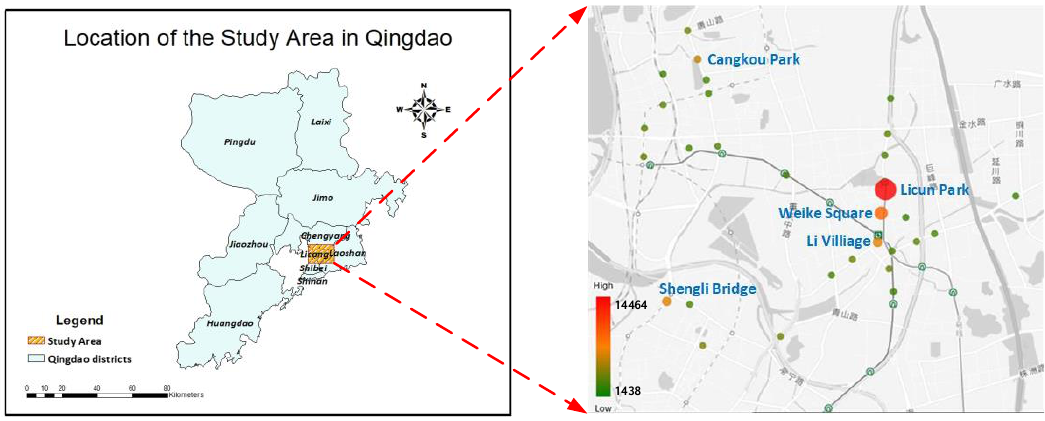
Figure 5. Location of study area and average daily passenger flow distribution.